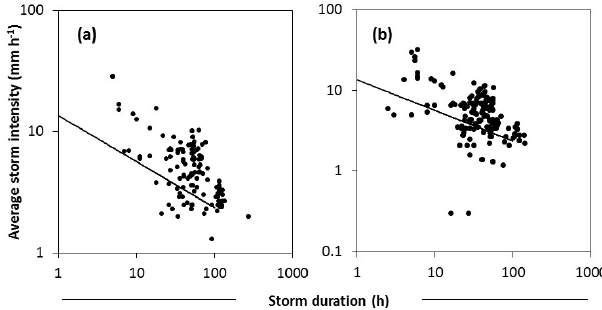
Figure 10. Average storm intensity–duration ( I – D ) relationships for the events that triggered landslides plotted along with the lower landslide threshold based on Eq. (3) (Sidle and Ochiai, 2006). (a) I – D relationships for the entire storm event; and (b) I – D relationships for average intensity and duration from the onset of the storm until landslide